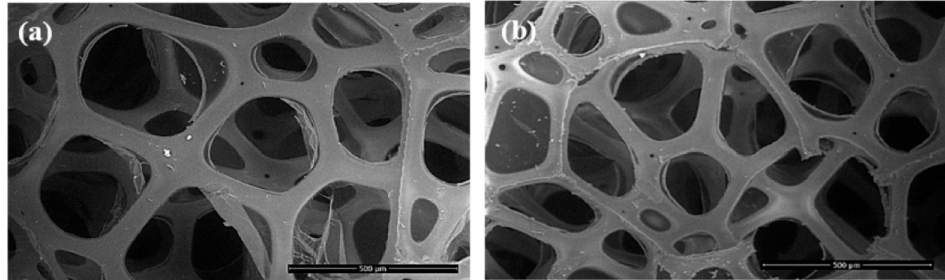
Figure 10. SEM images of the cellular structures of polyurethane foams obtained with reference polyol ( a ) and 30% recycled polyol (with N,N’ -bis[3-(dimethylamino)propyl]urea) ( b )